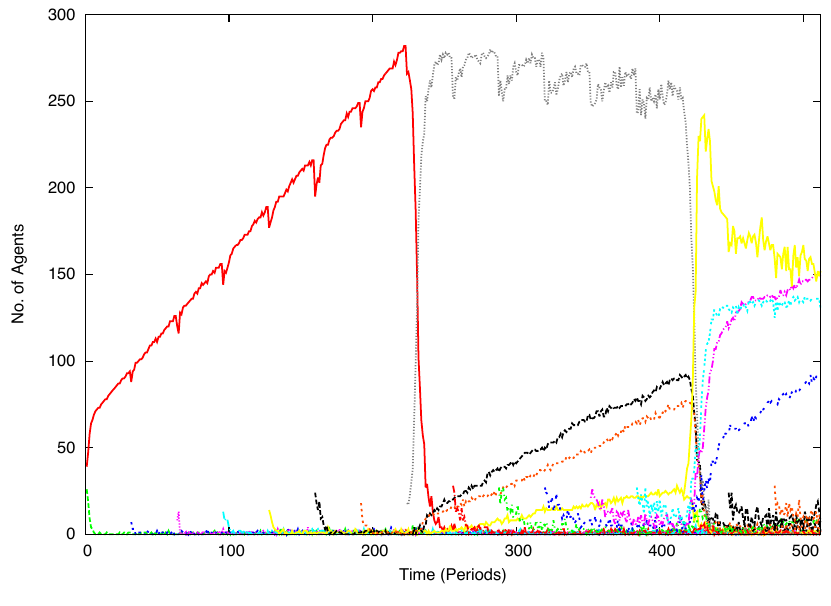
Figure 4. Development of the number of adherents to the different institutions (shown in different colors) for ↵ = 1 . 4